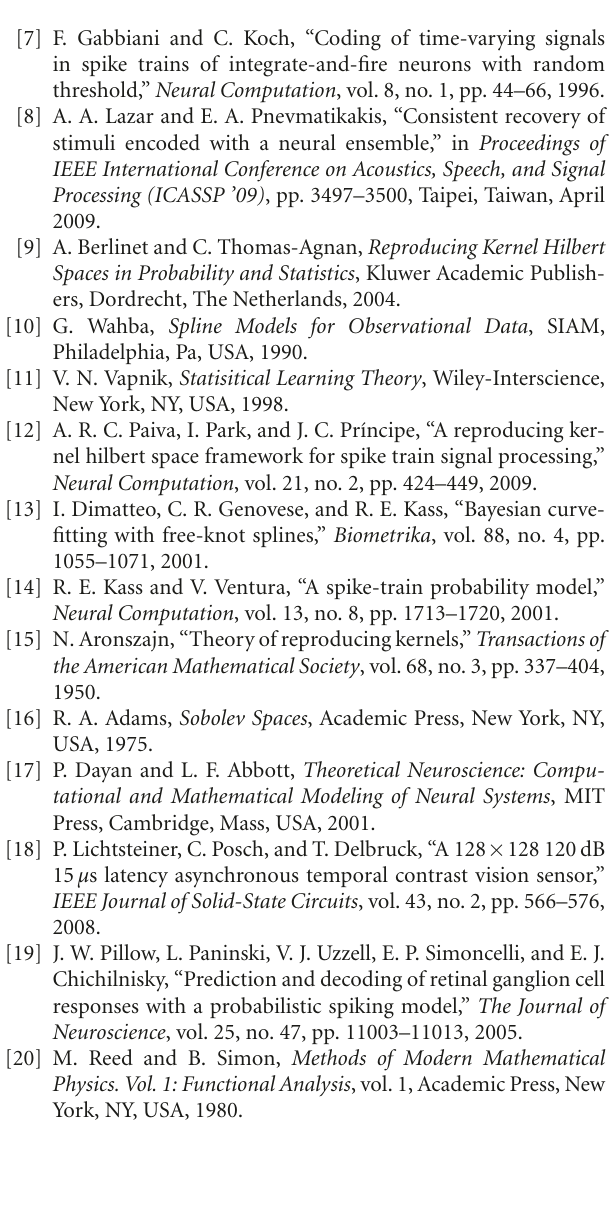
Algorithm 6. The optimal coe ffi cients c and d are given